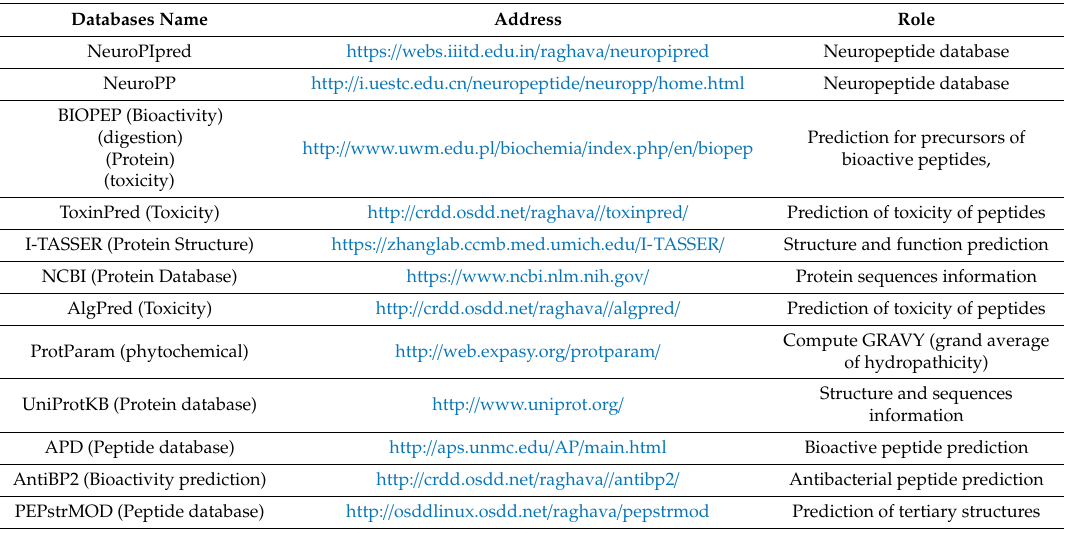
Table 6. In silico databases and online tools for analysis of bioactive